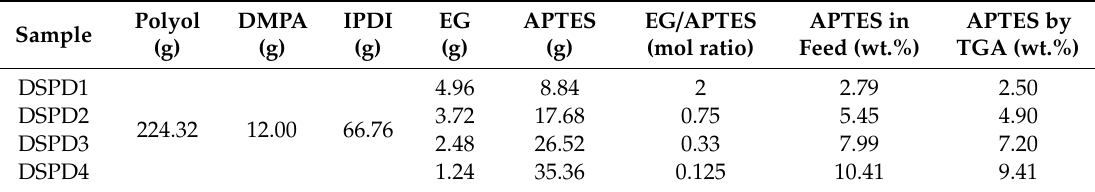
Table 1. Basic compositions of dimethylol propionic acid (DMPA) based silane terminated polyurethane dispersions